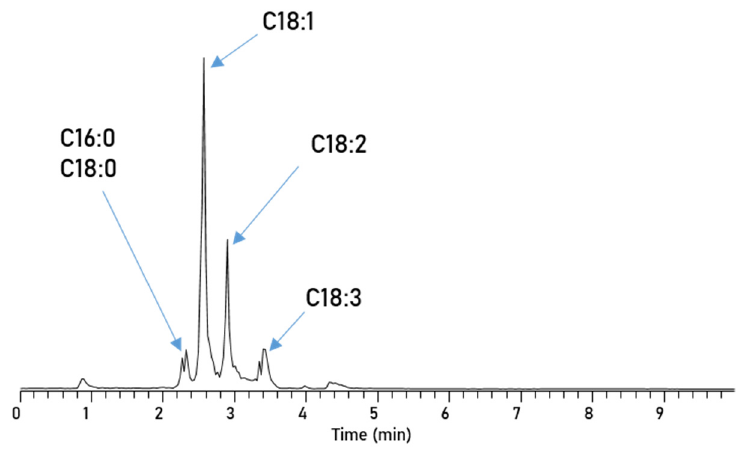
Figure 4. Chromatogram of RME, separated via an Amino-Column with Method 1.